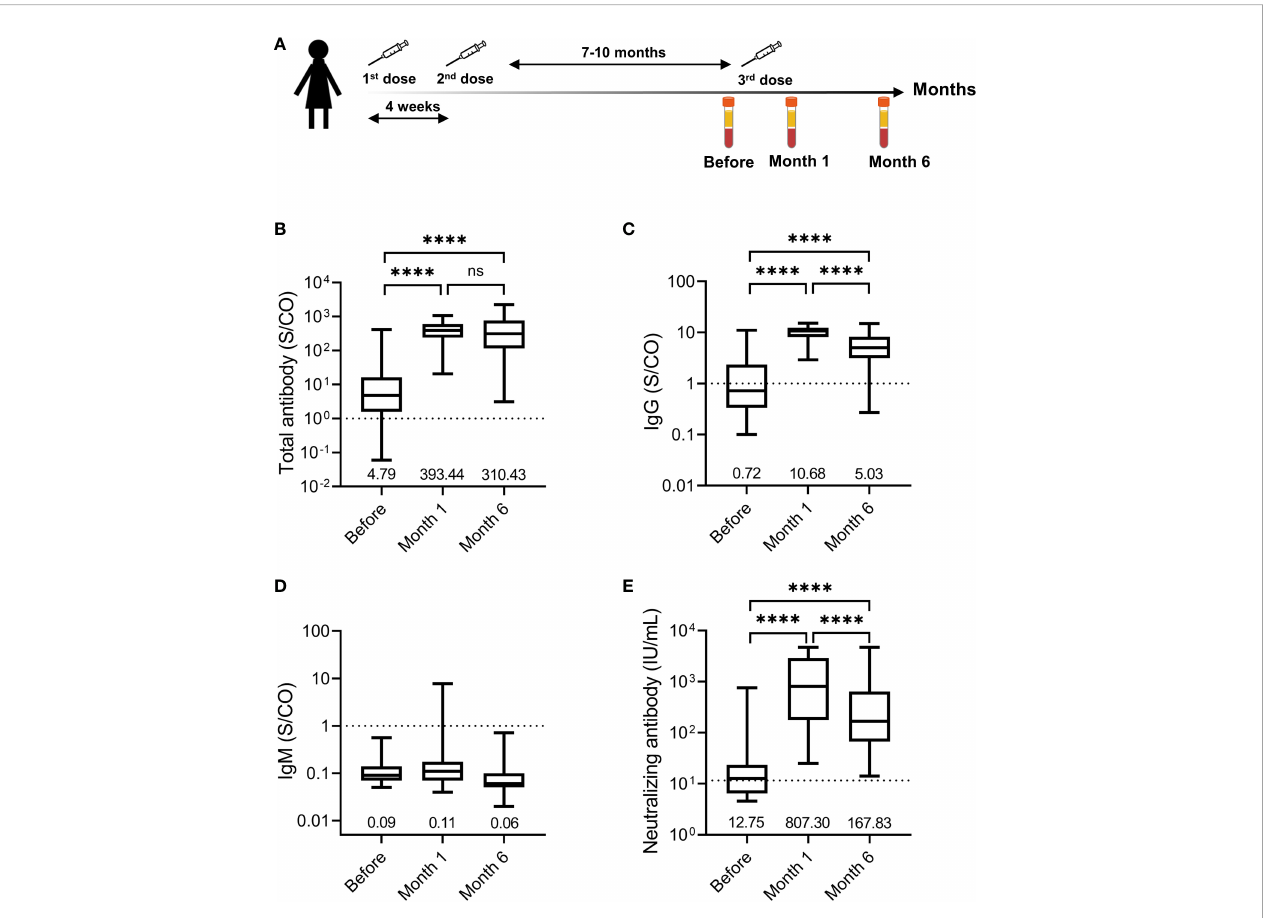
FIGURE 1 Humoral response induced by the third dose of homologous BBIBP-CorV inactivated vaccine. (A) Immunization regimen and time points of samples collected. The fi rst, second, and third doses are indicated above the time axis with needles, respectively. Three time points selected for serum samples collection are indicated below the time axis with blood collection tube. Levels of total antibody (B) , IgG antibody (C) , and IgM antibody (D) against the receptor binding domain (RBD) of the SARS-CoV-2 spike (S) protein and neutralizing antibody (E) against SARS-CoV-2 are shown as the range (whiskers), interquartile range (boxes) and median (line within the boxes) values. The median levels of total antibody, IgG antibody and IgM antibody against the RBD of the SARS-CoV-2 S protein and neutralizing antibody against SARS-CoV-2 are shown at the bottom of each panel. The dashed horizontal lines indicate the cut-off of total antibody, IgG antibody and IgM antibody against the RBD of the SARS-CoV-2 S protein and neutralizing antibody against SARS-CoV- 2. Comparisons were done by Wilcoxon matched-pairs sighed rank test (B-E) . ****p < 0.0001; ns, not signi fi